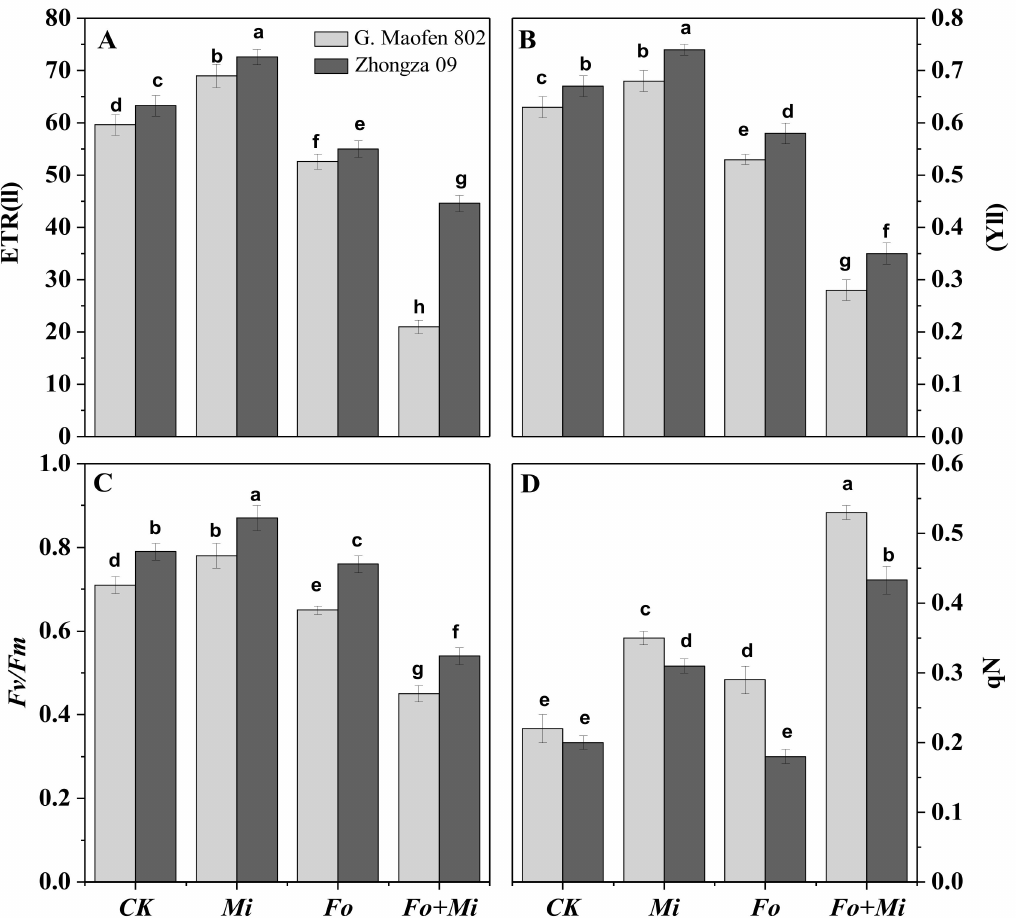
Figure 3. E ff ects of Fusarium oxysporum and Meloidogyne incognita alone and in combination on chlorophyll fluorescent parameters of two tomato cultivars (G. maofen 802 and Zhongza 09) under greenhouse conditions at 14 DAI: ( A ) the electron transport rate of PSII (ETR), ( B ) PSII quantum yield of light (YII), ( C ) potential quantum yield of photosystem II (Fv / Fm), and ( D ) non-photochemical quenching coe ffi cient (qN). Bars showing dissimilar lower-case letters are statistically di ff erent from each other at p ≤ 0.05 (Tukey–Kramer test). Values are mean ±